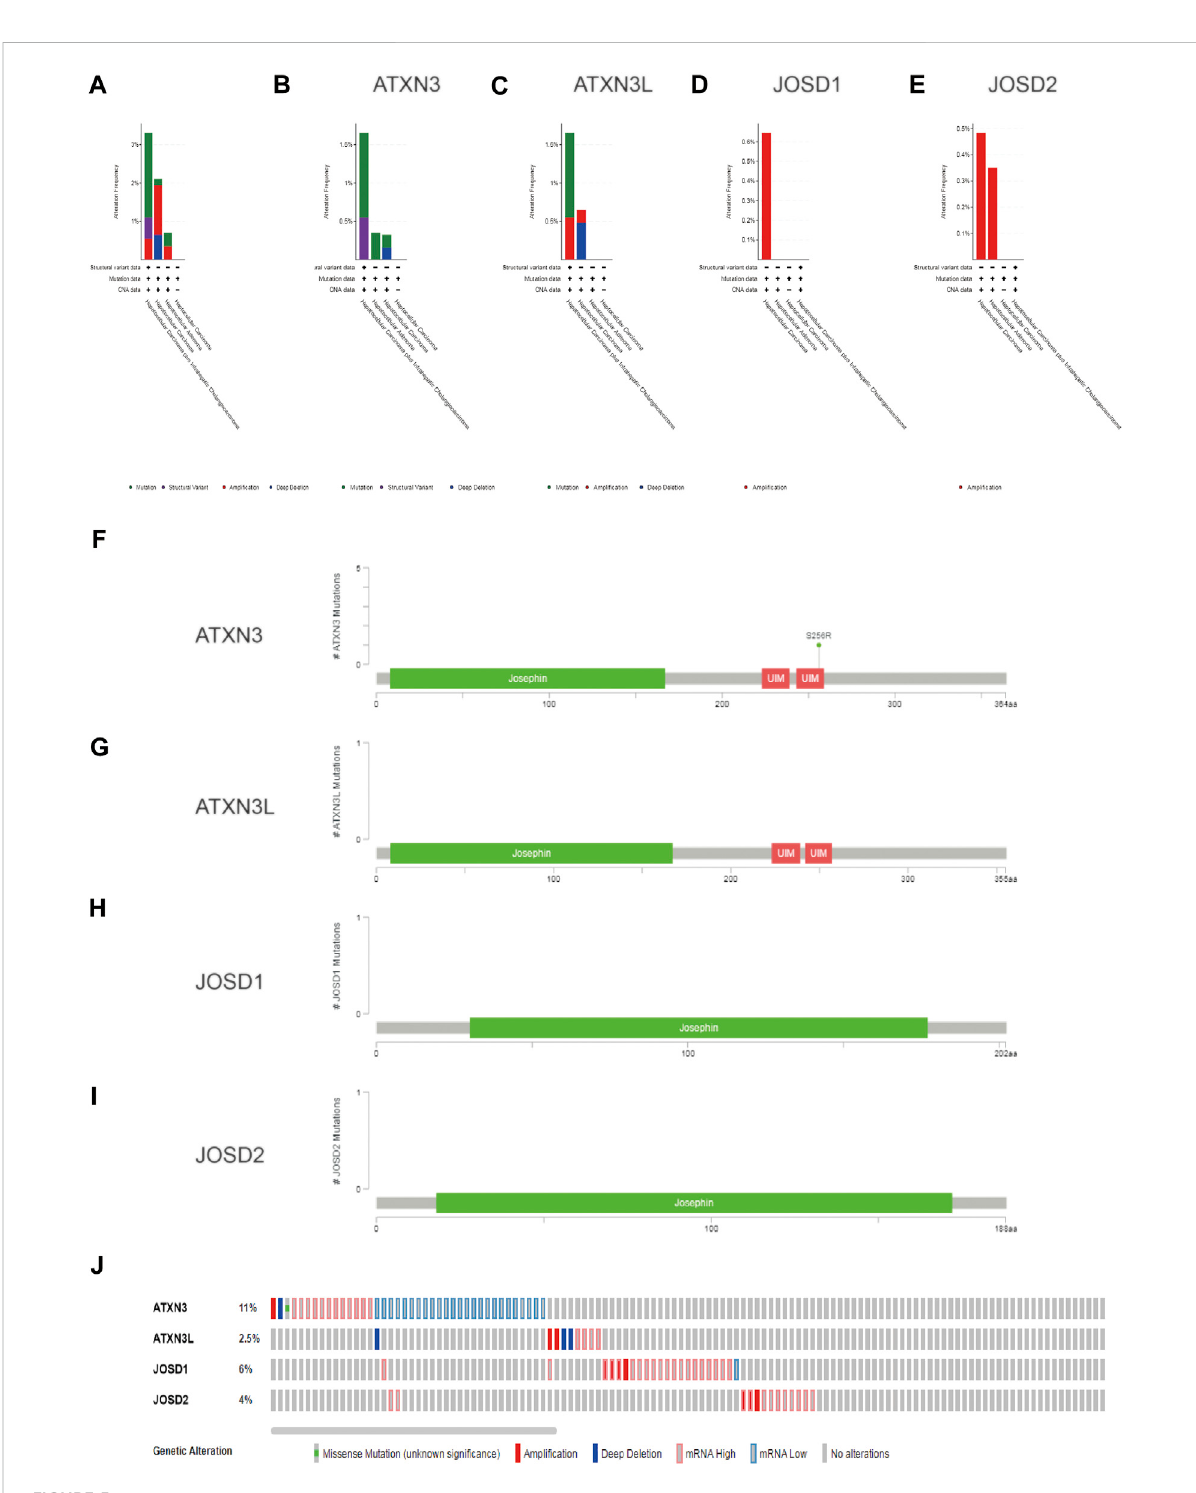
FIGURE 5 ThegeneticalterationandmutationofMJDsfamilymembersinHCC(cBioPortal) (A – E) TheproportionsofalternationsandmutationsofMJDs familymemberswereindicatedinvarioussubgroupsofHCC (F – I) .SchematicrepresentationofgenemutationsitesofMJDsonthecodingstrand (J) The genetic alternations and mutations of ATXN3, ATXN3L, JOSD1, and JOSD2 were showed in HCC patients (E)